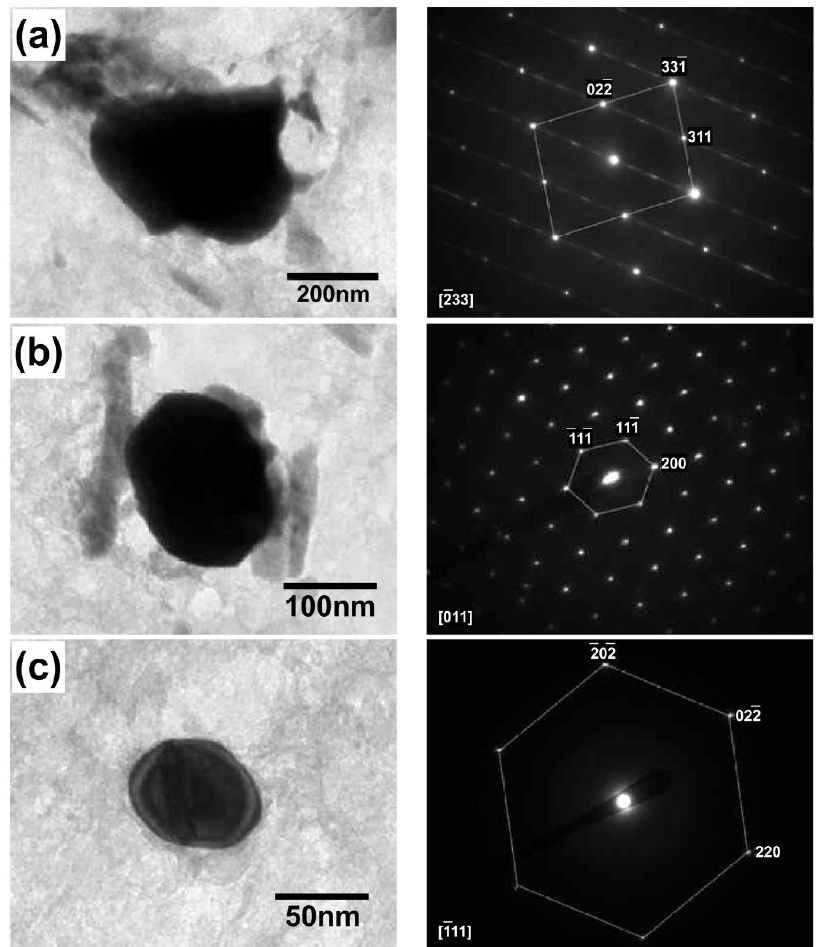
Figure 4. TEM images and the corresponding selected area electron diffraction (SAED) patterns for ( a ) M 7 C 3 precipitate; ( b ) M 6 C precipitate; and ( c ) (Mo,V)C precipitate.